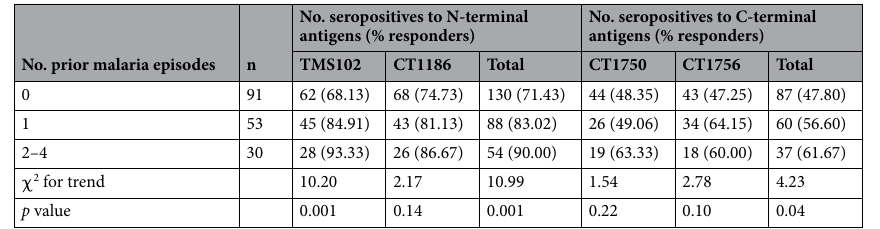
Table 3. Seropositivity rates of total IgG antibodies to PvMSP9 and previous malaria episodes.